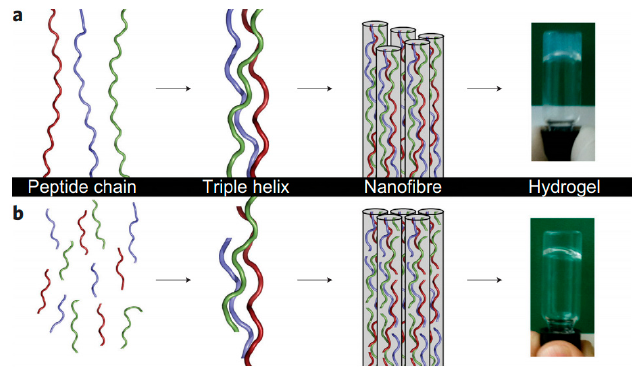
Figure 11. Comparison of self-assembling ( a ) natural rat tail tendon to ( b ) the synthetic